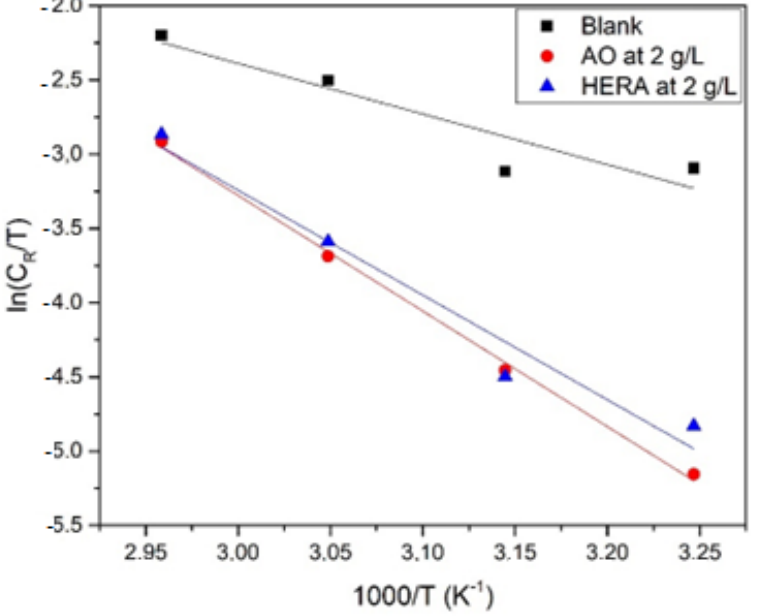
Figure 4. The alternative Arrhenius equation plots for steel in 1 M HCl in the absence and the presence of AO and HERA. Table 3. Activation parameters in the presence and absence of AO and